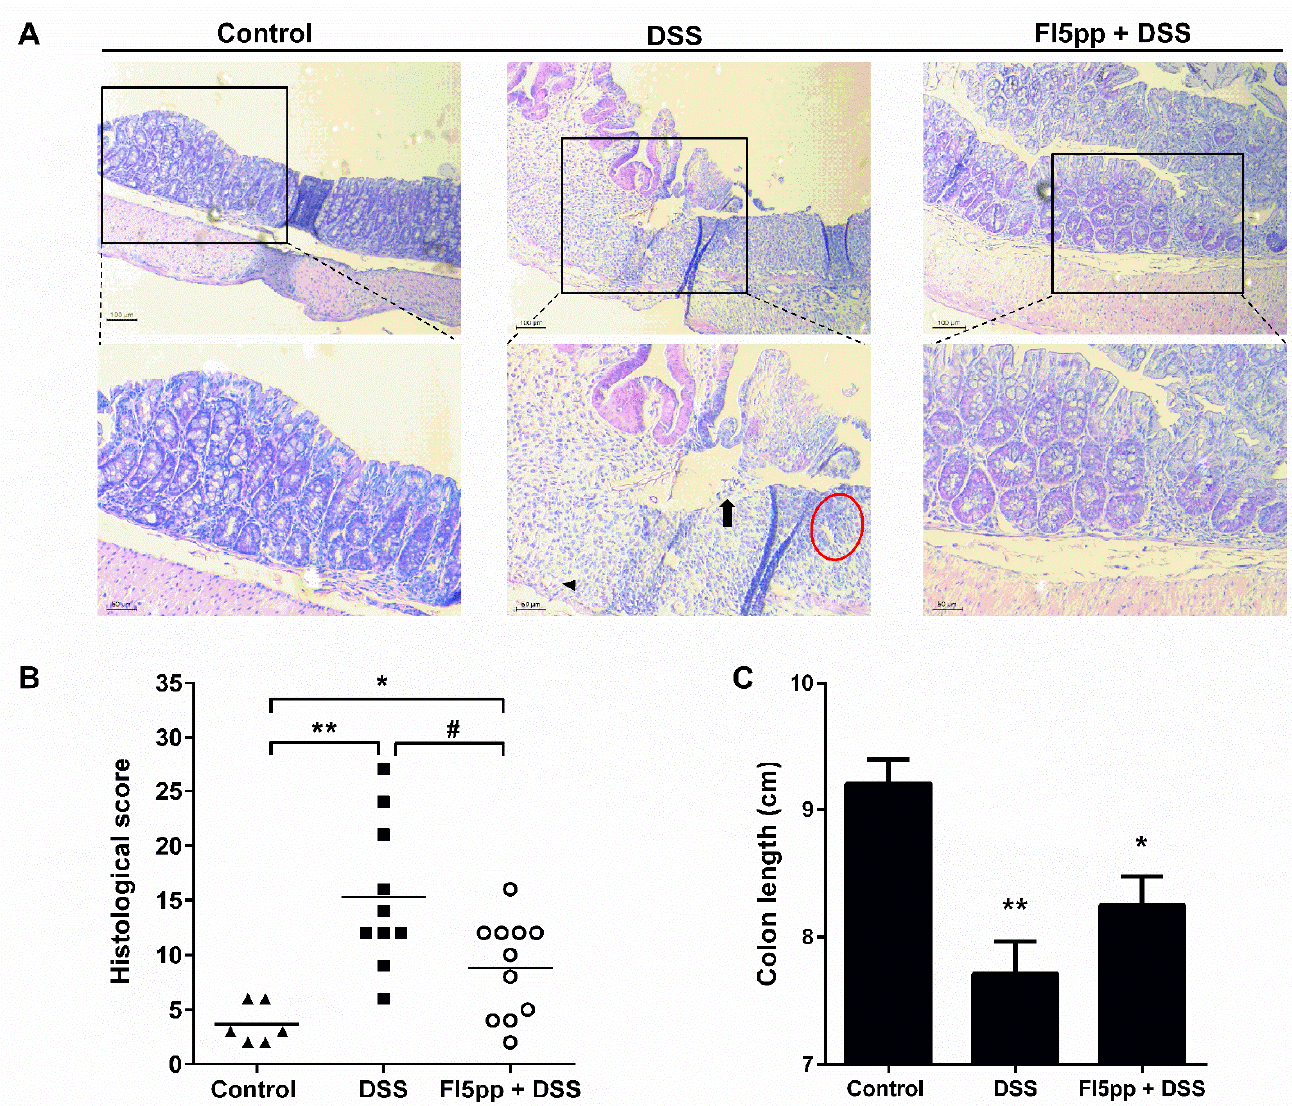
Figure 2. Histological changes in the colon are presented in representative histology images of hematoxylin and eosin (HE) stained colon sections ( A ). HE staining showed crypt distortion (arrow), epithelial damage (arrowhead) and inflammatory cell infiltration (red circle) in colon sections from DSS-treated mice. Corresponding histological score ( B ) and colon length ( C ) of mice with or without prophylactic FI5pp treatment. Results are expressed as mean ± SEM (“Control”, n = 6; “DSS”, n = 10; “FI5pp+DSS”, n = 11). *, p < 0.05, vs. control mice; **, p < 0.01 vs. control mice, #, p < 0.05, vs. DSS mice, as determined by Mann–Whitney U test. Scale bars: 100 µm (upper image panel) and 50 µm (lower image panel).